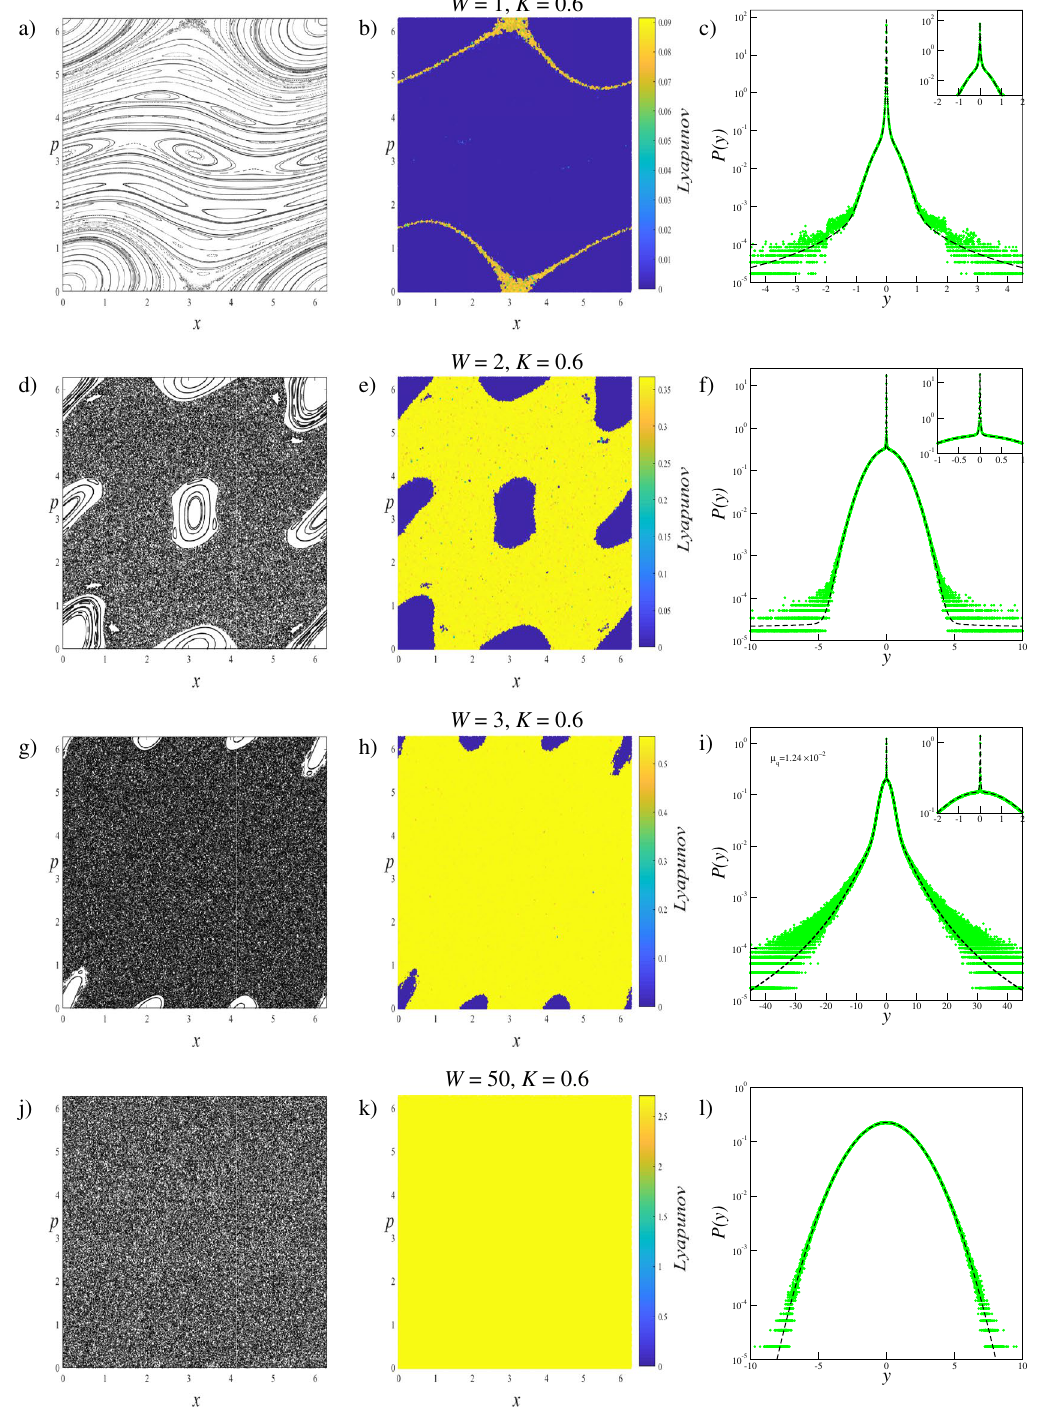
Figure 5. Analyses of the W = 1 , W = 2 , W = 3 , and W = 50 systems for K = 0.6 . Left column: ( a , d , g , j ) Phase space portraits, Middle column: ( b , e , h , k ) LLE color map descriptions of the phase portraits, Right column: ( c , f , i , l ) Probability distributions obtained from the initial conditions chosen from the entire phase